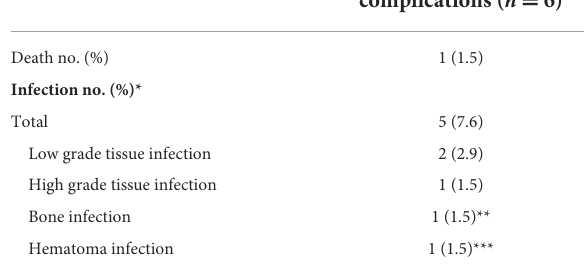
TABLE 4 Number of